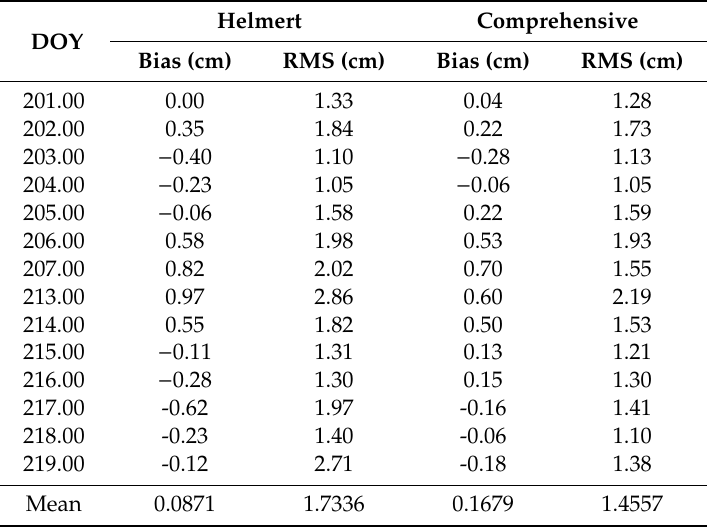
Table 2. Comparison of fusion model accuracy with two weighting methods. Helmert Comprehensive DOY Bias